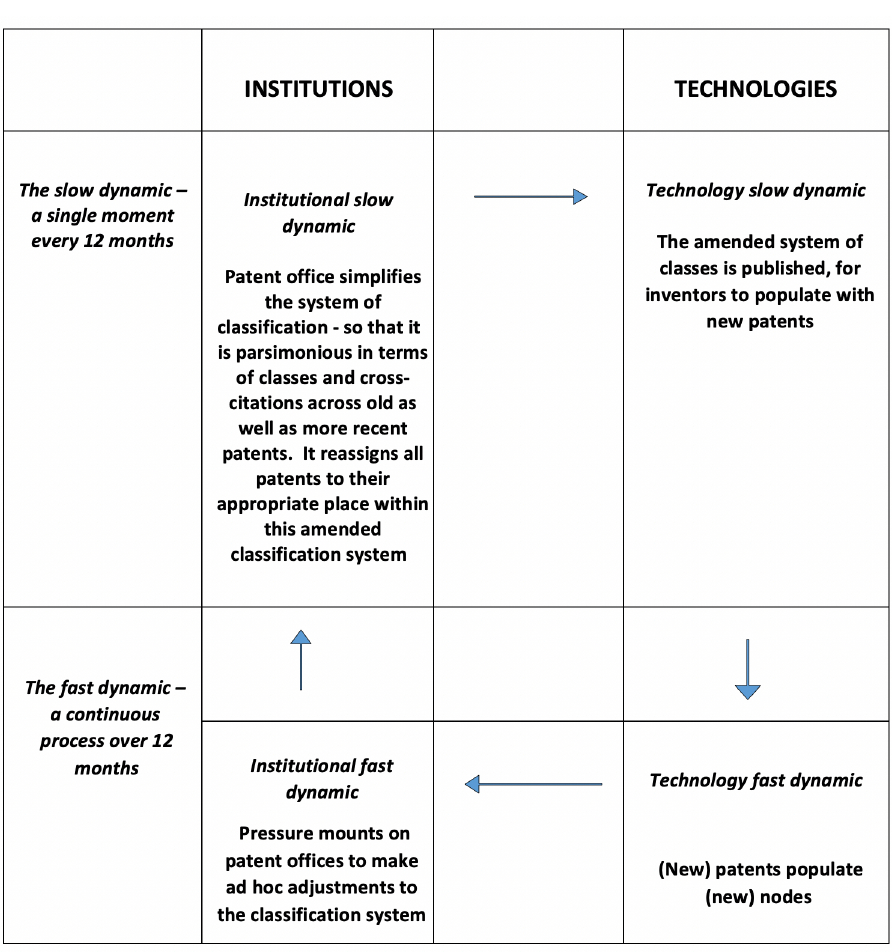
Figure 7. Patents as